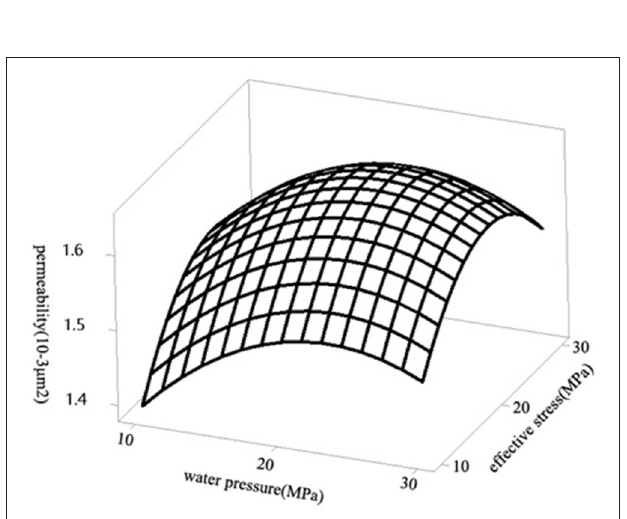
FIGURE 5 | Surface of permeability (10 − 3 µ m 2 ) vs. effective pressure and confining